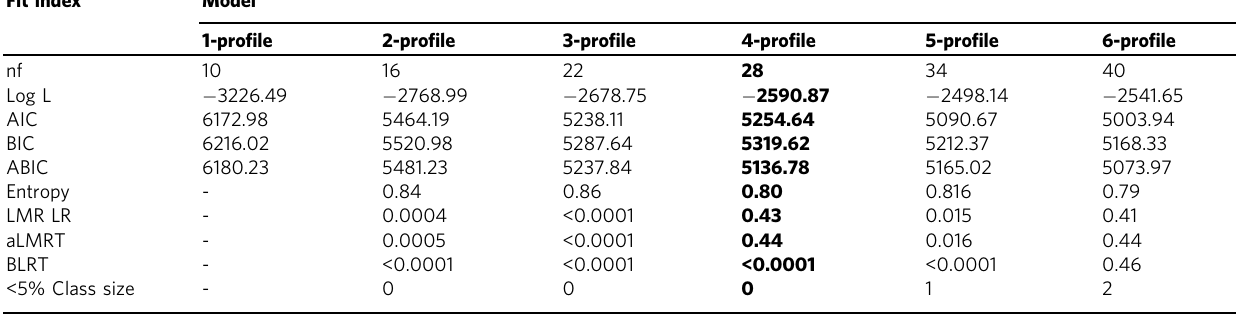
Table 4 Model fi t indices for the models with number of latent pro fi les ranging from 1 to 6.